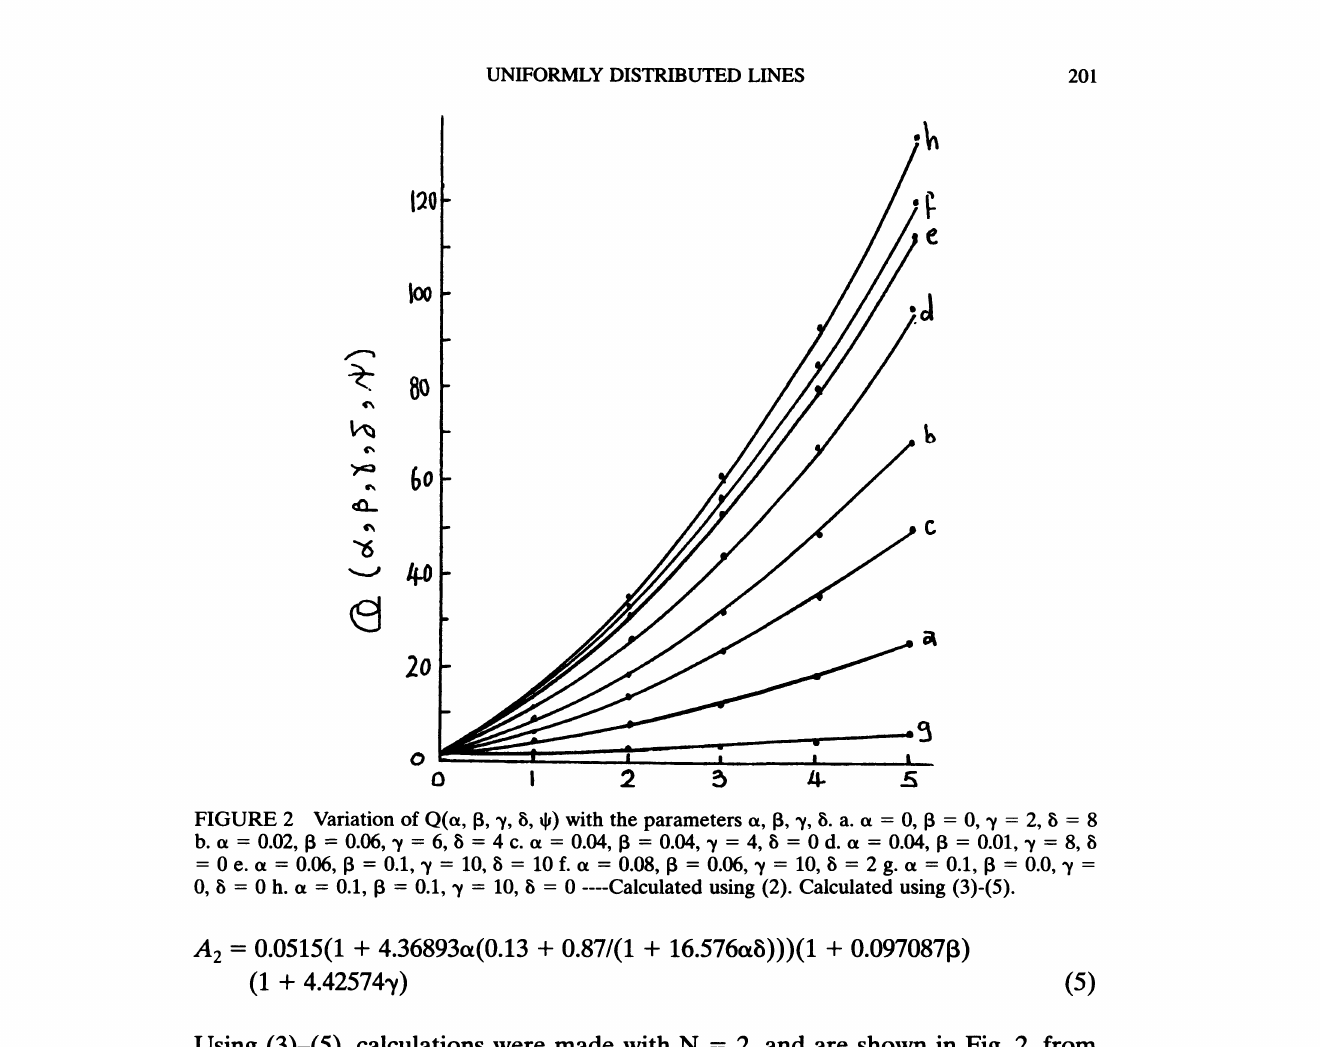
FIGURE 2 Variation of Q(c, 13, % i, ) with the parameters o, 13, % i. a. 0, 0, 2, 8 b.